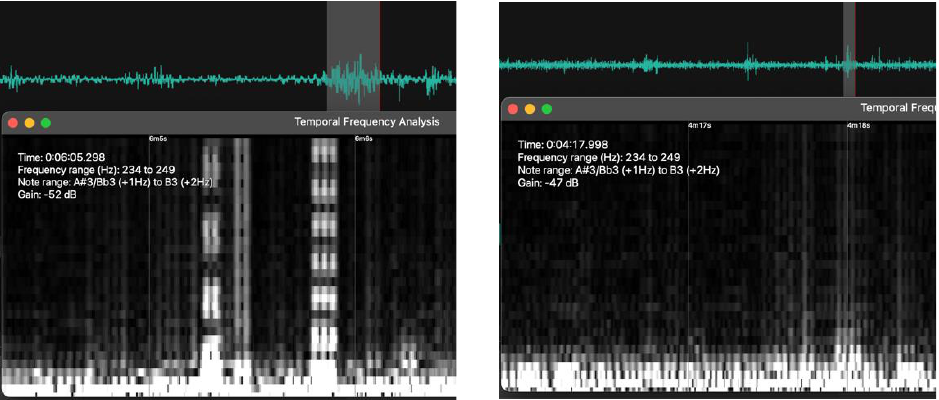
Figure 3. A temporal frequency analysis of the rumen sound signals showing two spikes highlighted (grey shade) and analyzed for their frequency range. Analysis performed using WavePad.